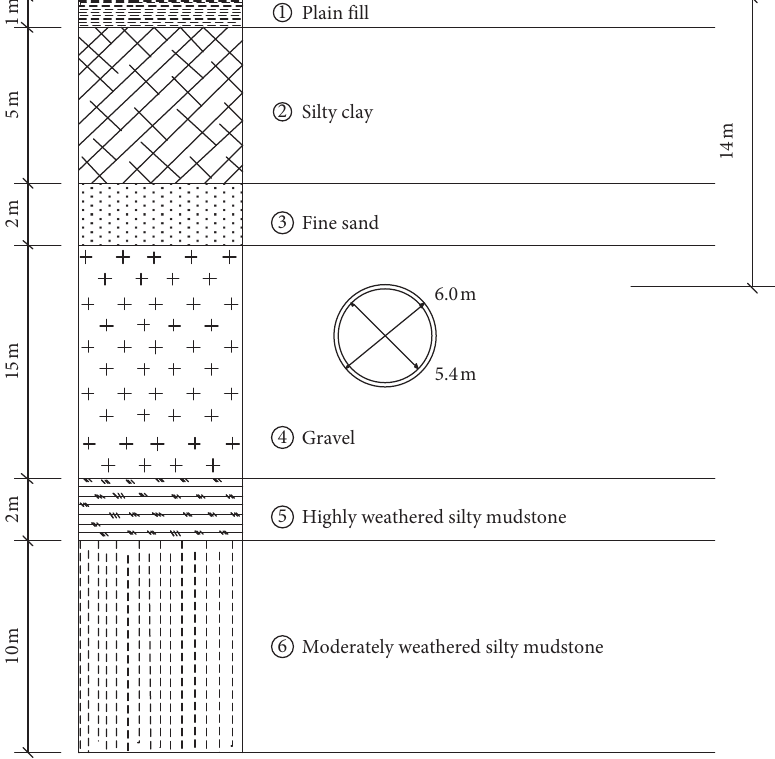
Figure 2: Profile of soil layers surrounding the shield tunnel. Table 1: Excavation design for the concerned shield tunneling interval. Step no. Excavation time Ring no.